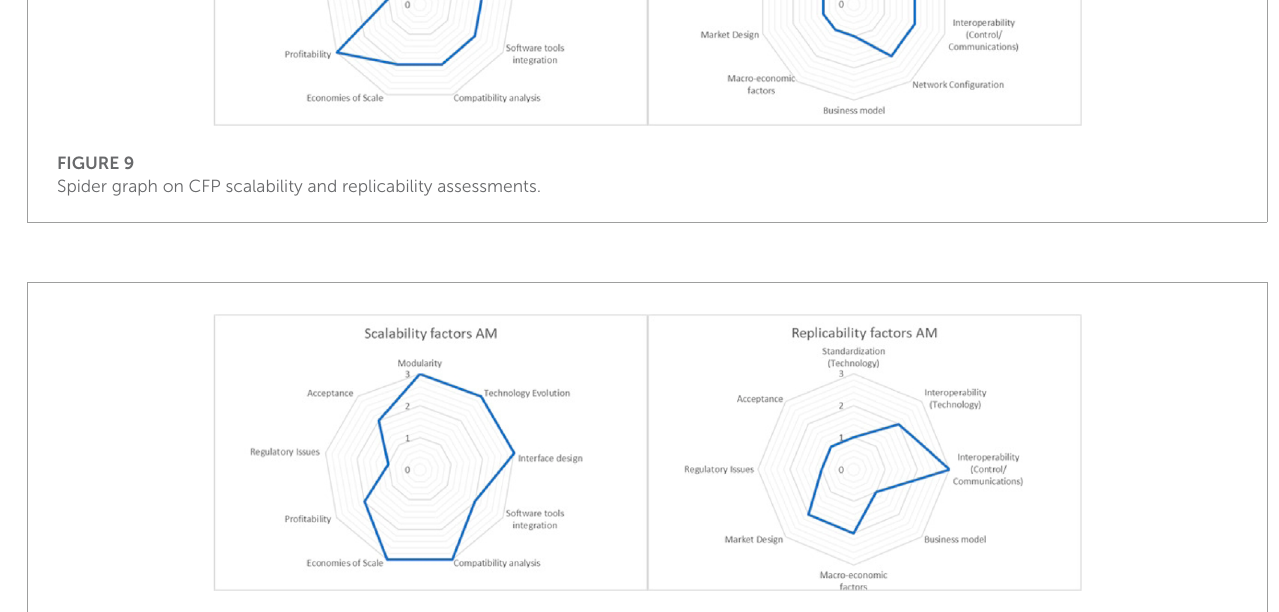
FIGURE 10 Spider graph on AM scalability and replicability assessments.